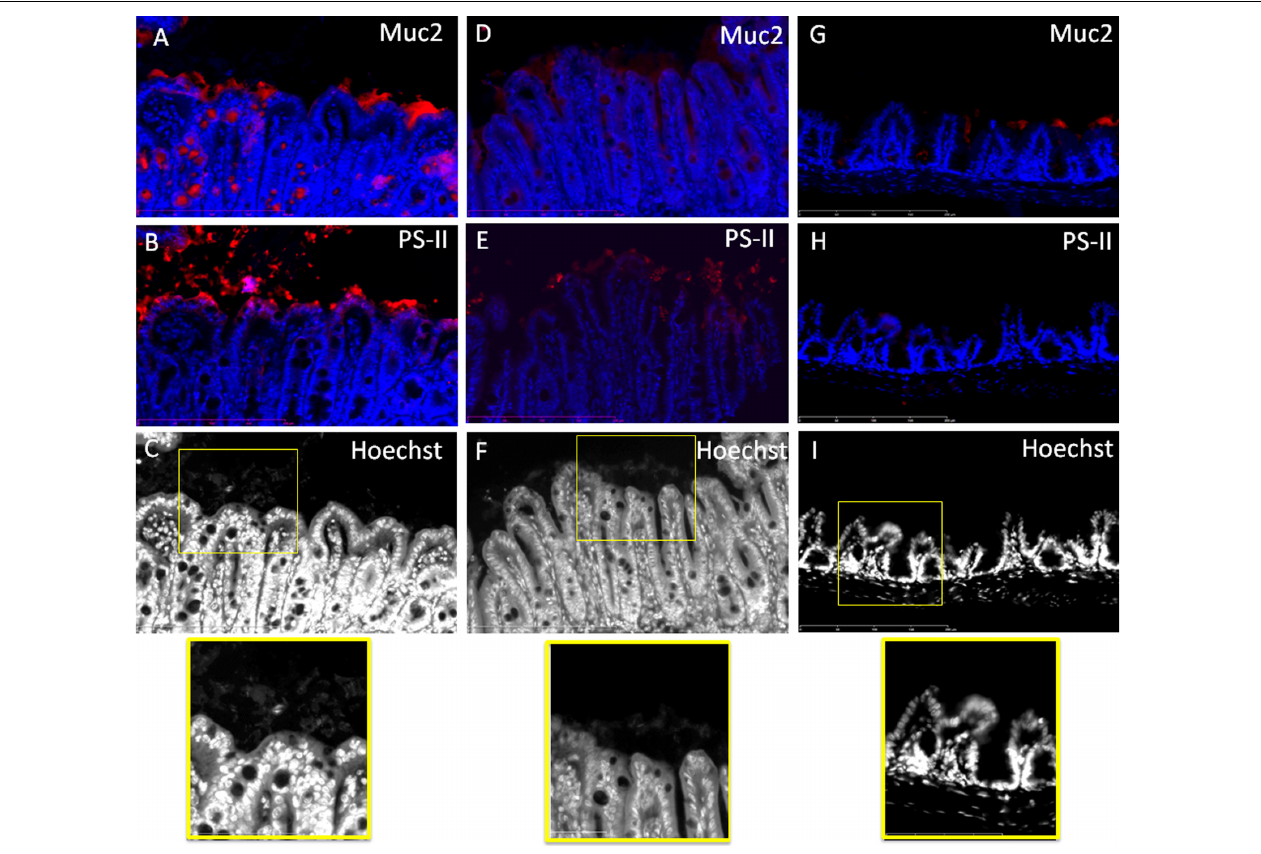
FIGURE 4 | Bacteria localized outside the mucus are embedded in a PS-II matrix in the cecum of R20291-infected mice. Comparison of stained serial sections (A–C) (D–F) (G–I) . (A,B) and (D,E) Represent two different areas of the cecum of mouse infected by the R20291 strain. (G,H) Are serial sections from germ-free mouse. Mucus and PS-II are stained in red and DNA (bacteria and epithelial tissue, extracellular DNA) are stained in blue or gray. The bottom panel is the enlarged section of the yellow boxed portion of the image. Scale bar is 200 µ